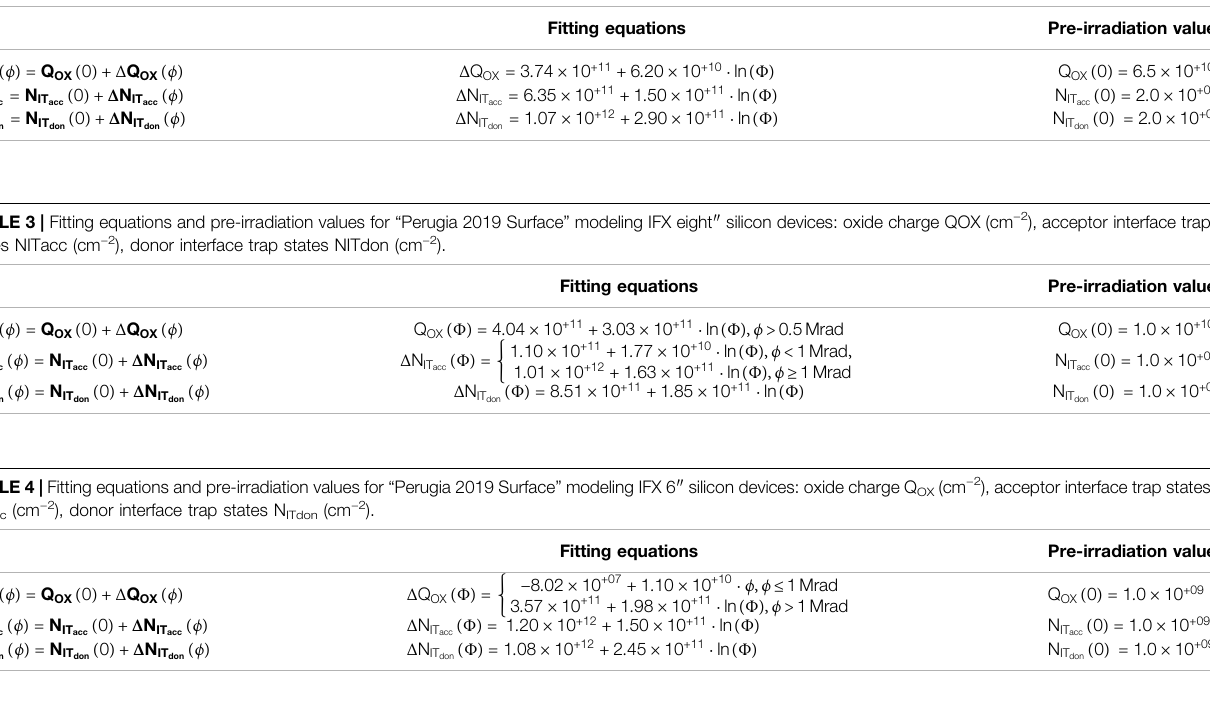
TABLE 5 | Fitting equations and pre-irradiation values for the “ Perugia 2019 Surface ” modeling FBK silicon devices: oxide charge Q OX (cm − 2 ), acceptor interface trap states N ITacc (cm − 2 ), donor interface trap states N ITdon (cm − 2 ). Fitting equations Pre-irradiation